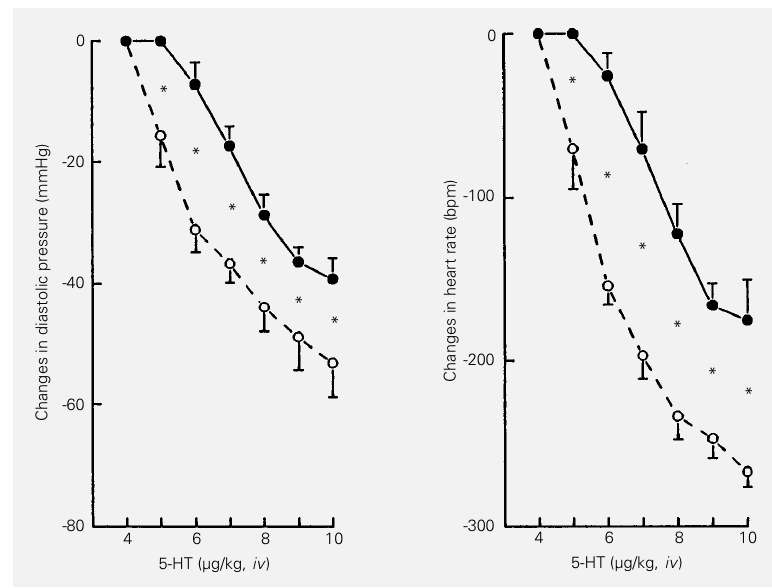
Figure 5 - 5-Hydroxytryptamine (5-HT)-induced Bezold-Jarisch reflex in hypertension caused by the inhibitor of nitric oxide synthase N-nitro-L-arginine methyl ester (L-NAME, 0.5 mg/ml added to the drinking water for 6 days). Open circles: L-NAME-treated rats (N = 9); filled circles: control rats (N = 9). *P<0.05 compared to the control group (ANOVA). Reproduced from Ref. 51, with